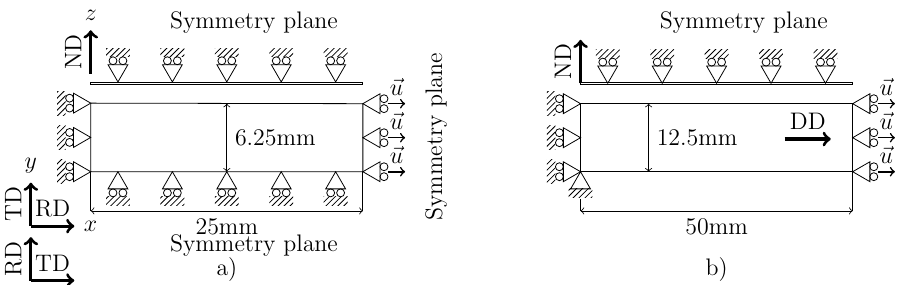
Figure 4. Tensile test boundary conditions for the ( a ) RD and TD and ( b ) DD specimens (side and top views).